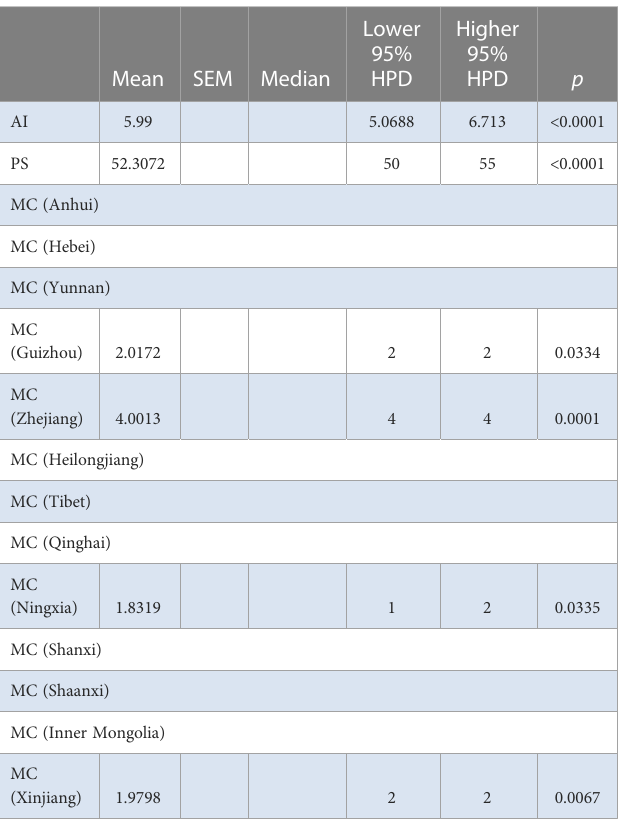
TABLE 3 BaTS analysis for the different provinces of China.